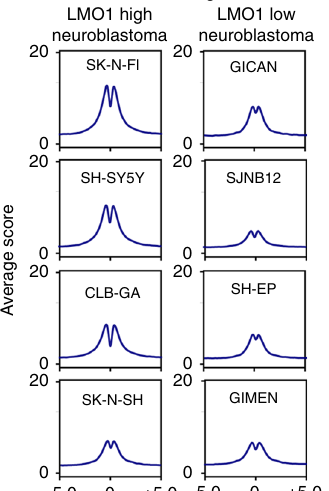
Distance (kb) from the center of non-promoter regions of LMO1 binding in Kelly Fig. 2 LMO1 co-occupies targets with the members of the ADRN CRC. a The LMO1-bound nonpromoter loci were fi rst identi fi ed in Kelly cells. Density plots show the distribution of LMO1, GATA3, MYCN, PHOX2B, HAND2, TBX2 and ISL1, H3K27ac and H3K4me1 signals at the LMO1-bound regions (±3 kb from binding sites) in Kelly and LMO1, GATA3, H3K27ac and H3K4me1 signals at the same regions in Jurkat cells. The color scale shows the intensity of the distribution signal. b Metagene plots show distribution of LMO1, GATA3, MYCN, H3K27ac, and H3K4me1 signals at the LMO1-bound regions (±3 kb from binding sites) in Kelly and Jurkat cells. c Metagene plots show distribution of H3K27ac signals at the LMO1-bound regions (±5 kb from binding sites) in various neuroblastoma cell lines. Cell lines were classi fi ed based on the expression level of LMO1